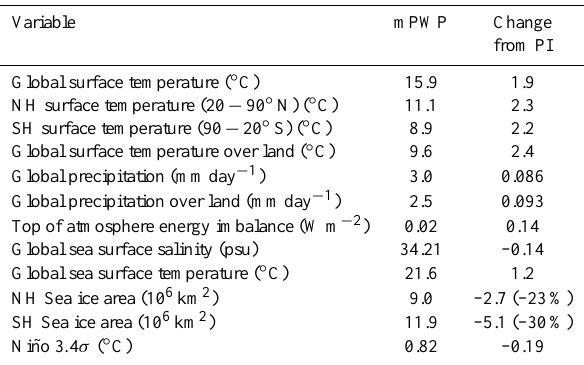
Table 2. Summary of CCSM4 model response. Variable